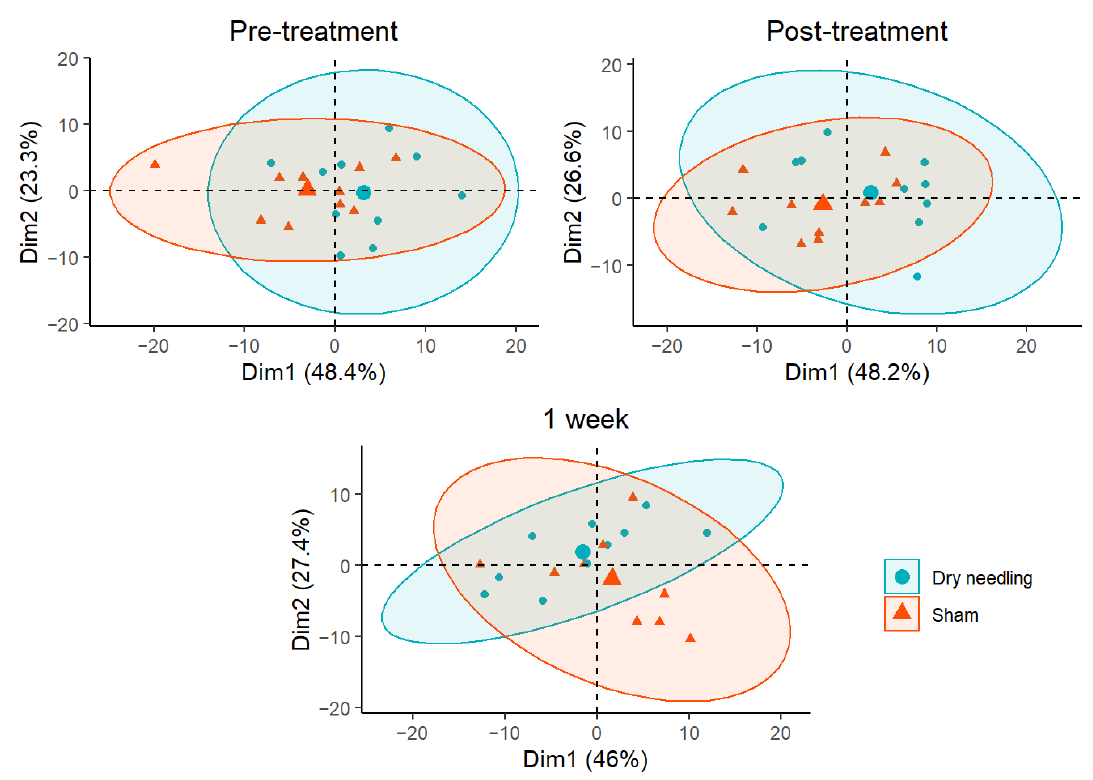
Figure 3. Graphic of individuals in each group.